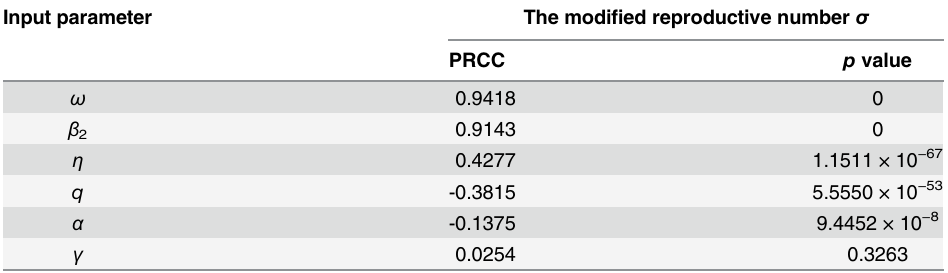
Table 5. Partial rank correlation coefficients(PRCCs) for the aggregate σ and each input parameter variable.